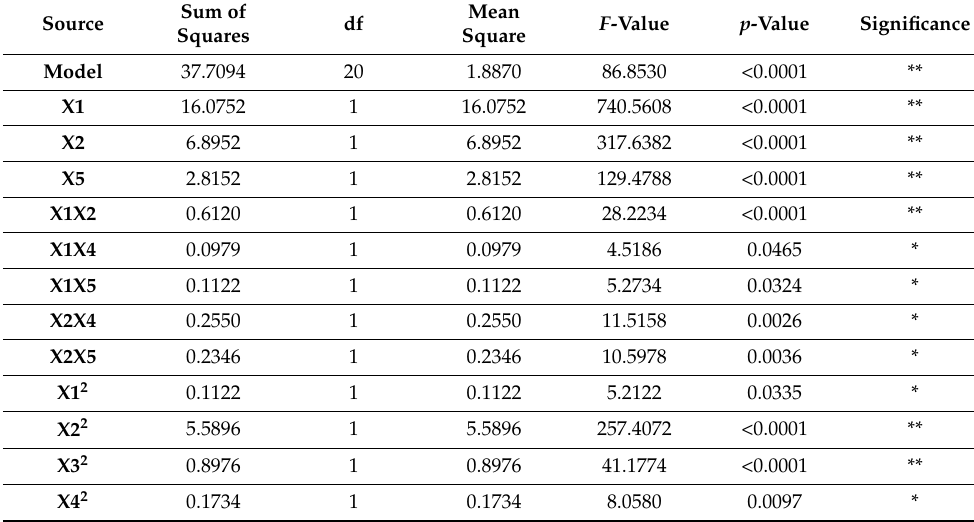
Table 3. ANOVA of the central composite